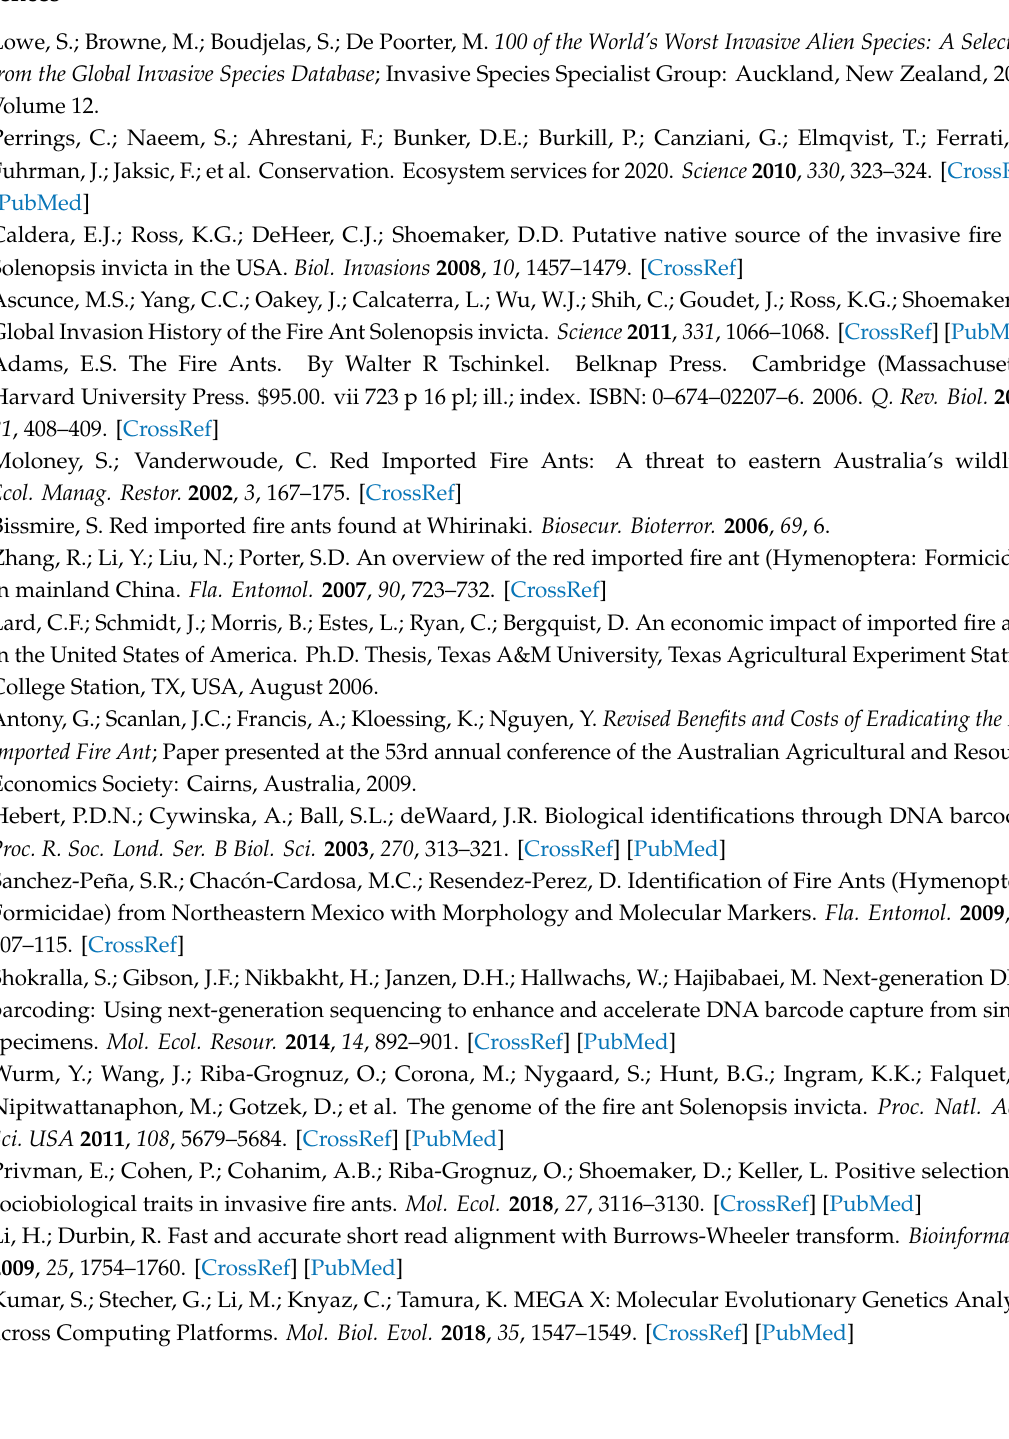
consolidated genotype matrix, Table S3: Gene list showing high scores for the classification between S. invicta and S. geminata , Table S4: Sanger validation of genotype calls in COX1 gene region, File S1: the genotype matrix of 43 Solenopsis